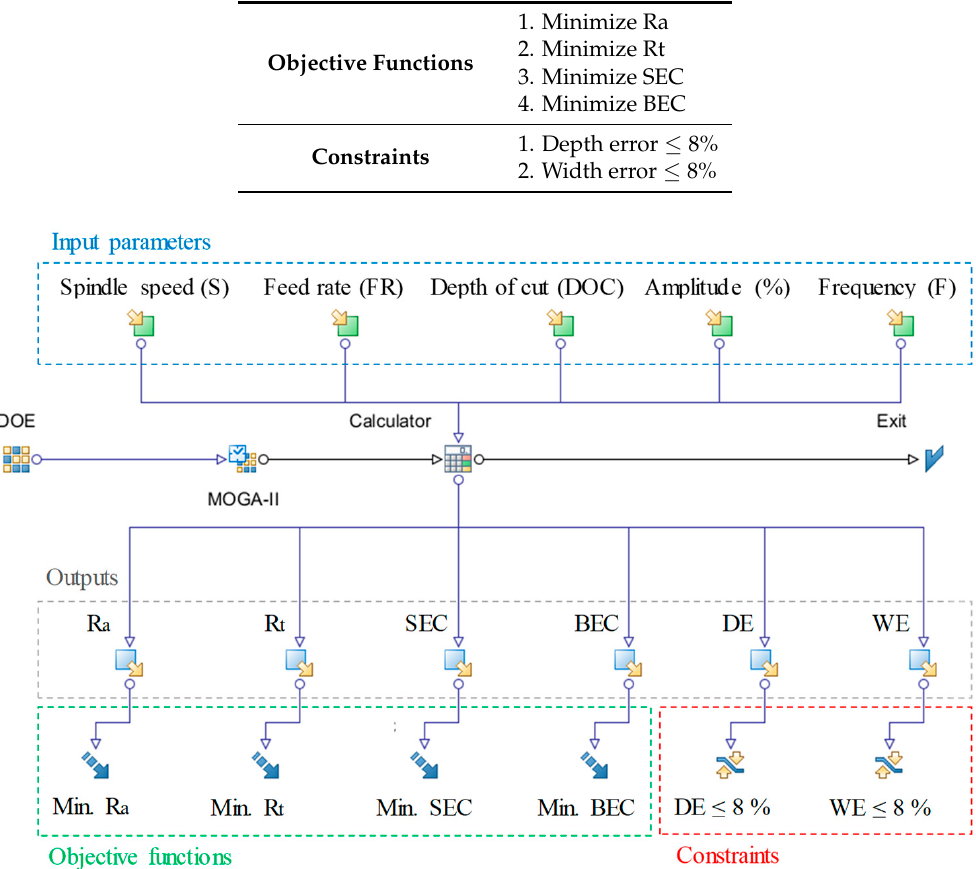
Figure 17. Process flow for the optimization problem.